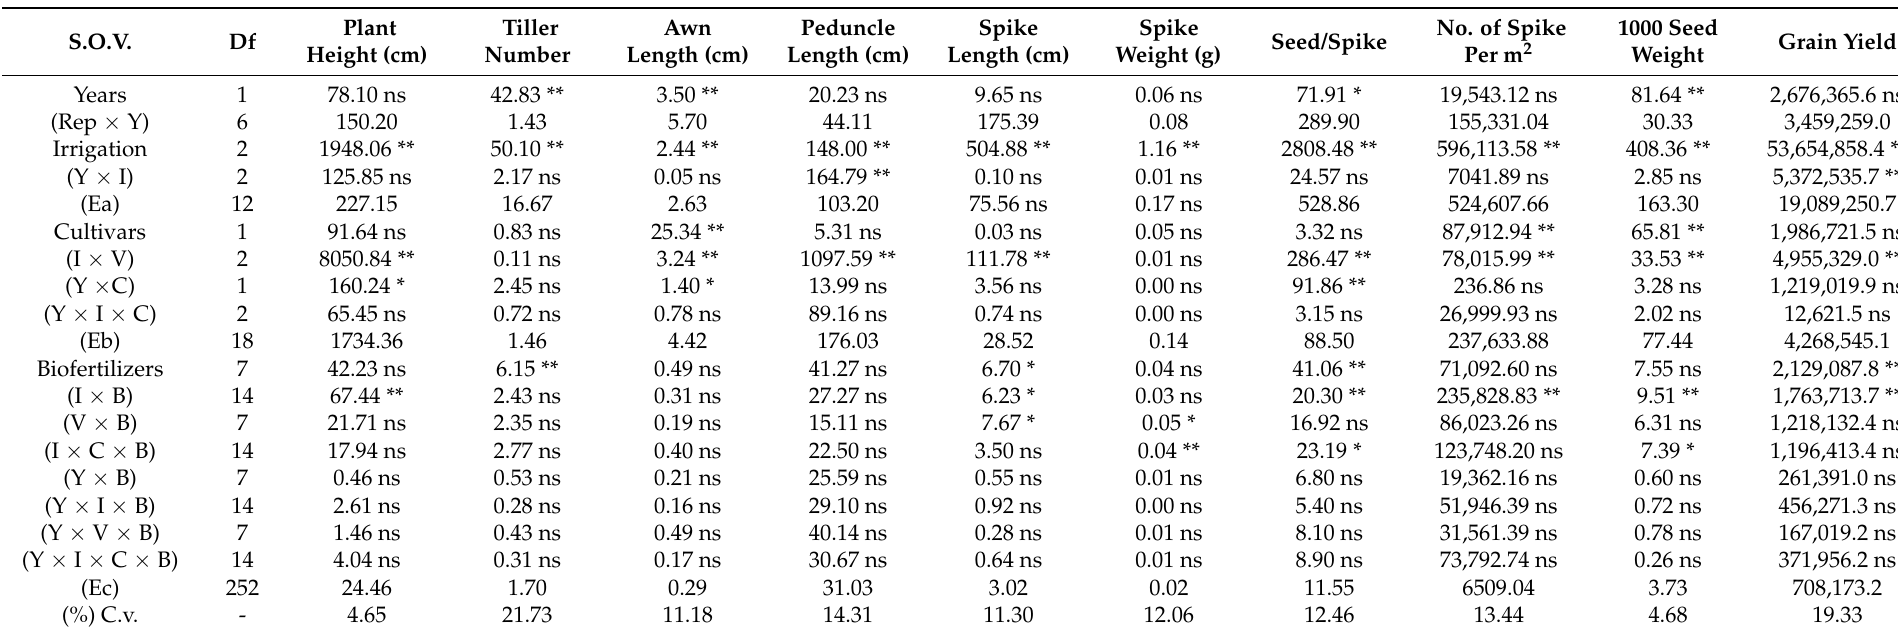
Table 1. Analysis of variance (mean of squares) of the physiological traits of wheat under the effect of supplementary irrigation and biofertilizers in the studied